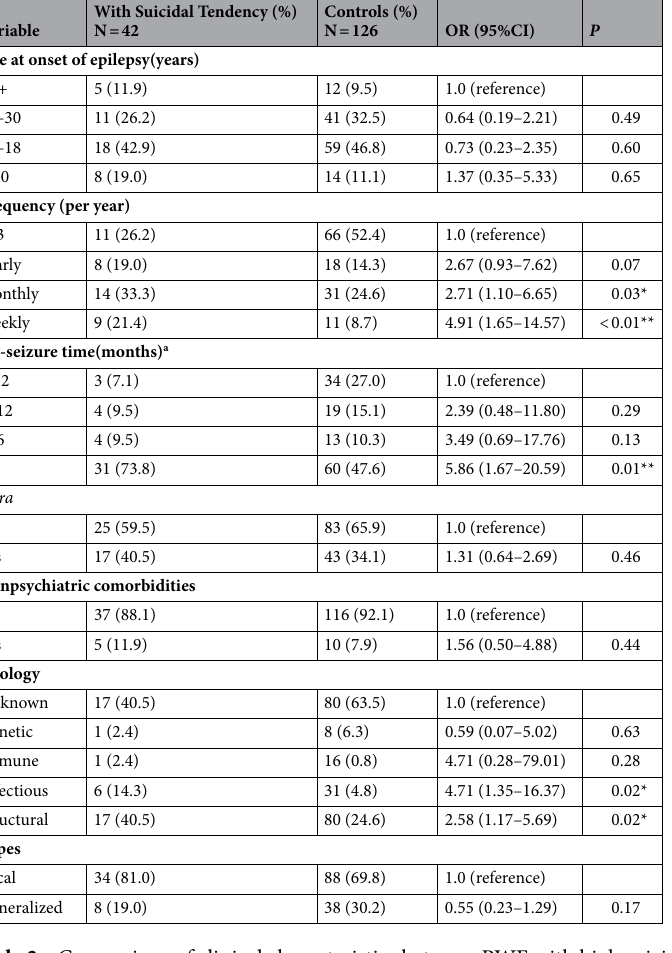
Table 2. Comparison of clinical characteristics between PWE with high suicidal tendency and PWE without (Result of using univariable analysis). a No-seizure time: The time(month) without seizure occurring. CI confidence interval, OR odds ratio. * P < 0.05; ** P <